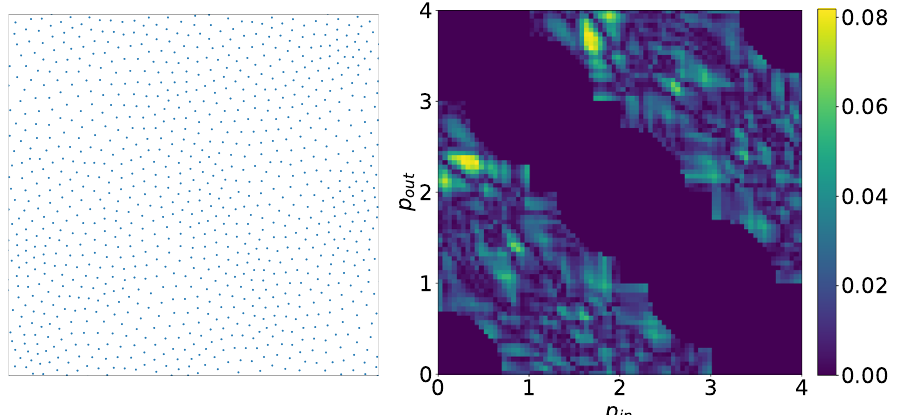
Figure 30 . The point data (left panel) and the | ¯Γ[ C ] | heatmap (right panel) for a representative pure-background pseudo-experiment entering the blue histogram in figure